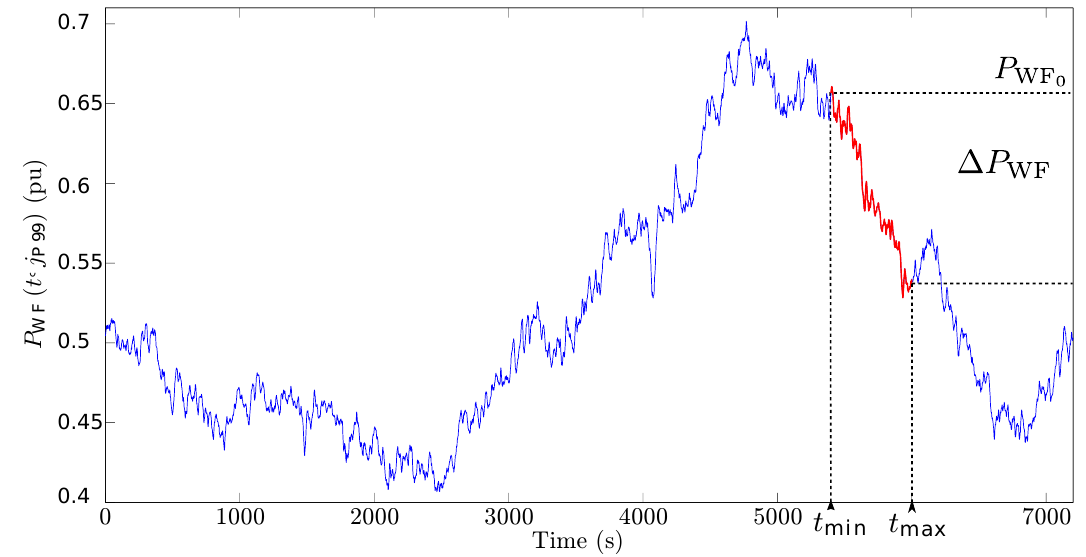
Figure 9. Wind farm power in 2-h time interval, expressed as per unit of installed wind power. In red, the 10-min interval used in the simulations.